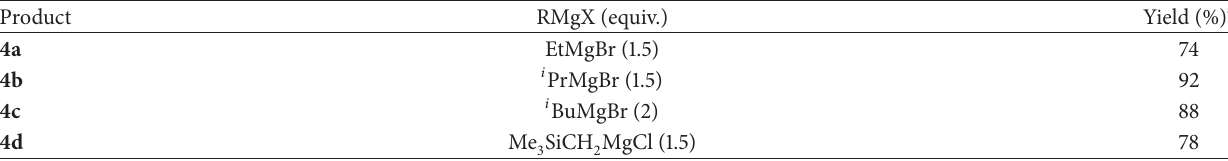
Table 2: Synthesis of diethyl 1-[(alkyl)(cyano)methyl]vinylphosphonates 4a–d